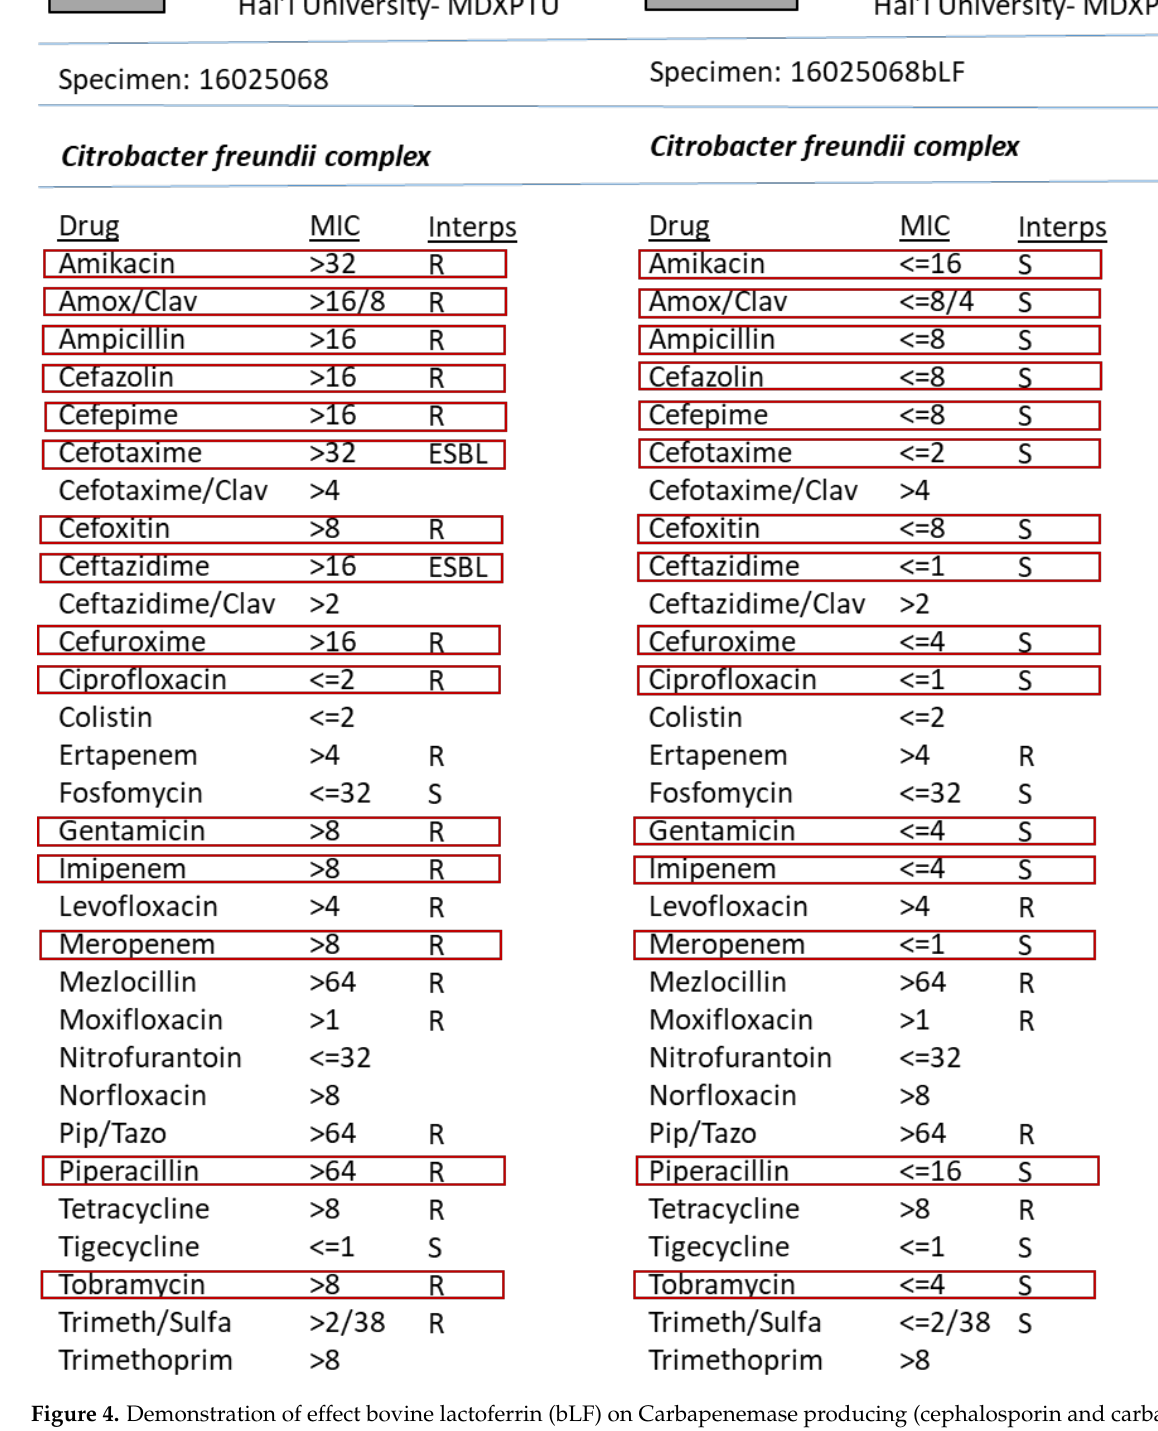
Figure 4. Demonstration of effect bovine lactoferrin (bLF) on Carbapenemase producing (cephalosporin and carbapenem resistant) and ciprofloxacin resistant Citrobacter freundii